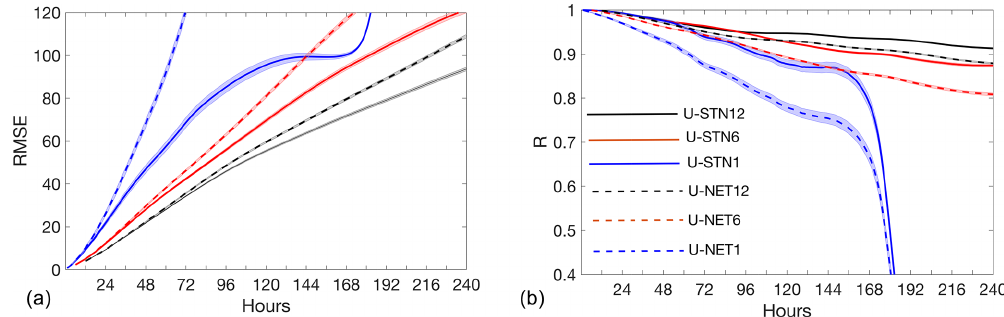
Figure 6. Panels (a) and (b) show RMSE ( R ) between noise-free data from ERA5 and the forecasts from U-STNx or U-NETx from 30 random, noise-free initial conditions. No DA is used here. RMSE is in meters. The lines (shading) show the mean (standard deviation) of the 30 forecasts.